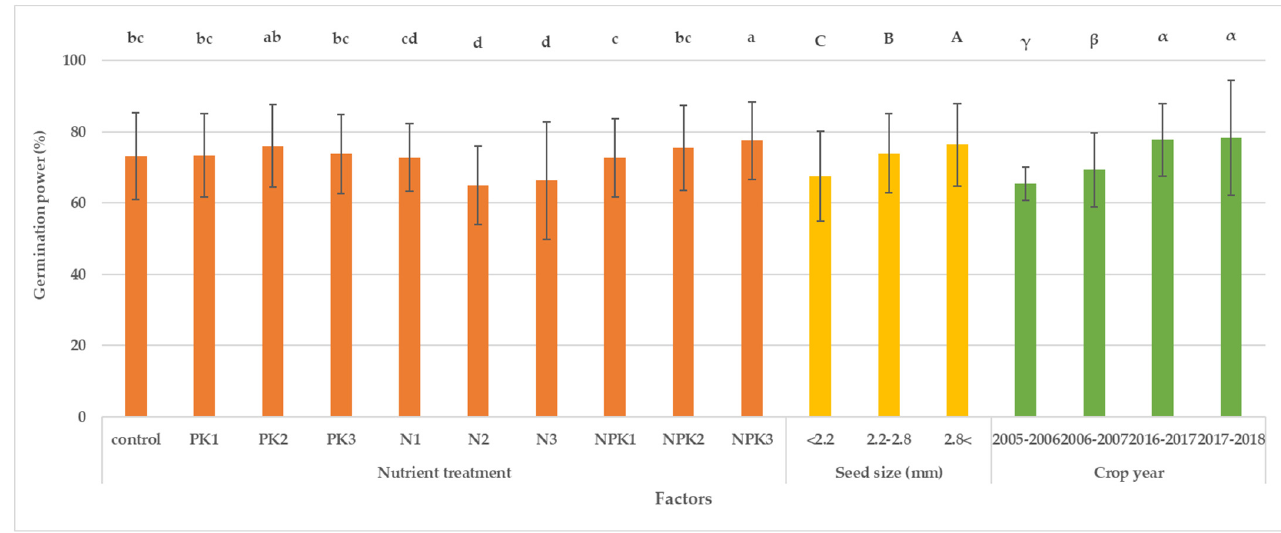
Figure 2. Effect of nutrient treatments, seed size and crop year on germination power of winter wheat. (Values marked with different letters are significantly different at the p < 0.05 significance level. Small letters (a–d) represent nutrient treatments, capital letters (A–C) represent seed sizes and Greek letters ( α – γ ) represent years, where the order of the letters starts from the largest value. The standard deviation (SD) has been marked in the columns.)